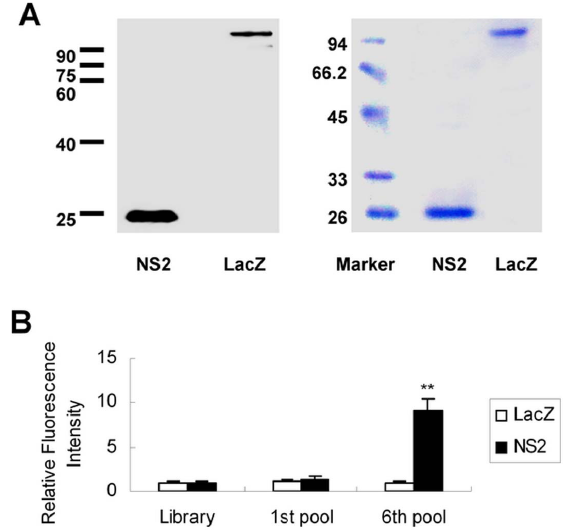
Figure 1. Binding of DNA pools from round 1 and round 6 to NS2 protein. ( A ) Western blot analysis of purified NS2 protein. His- tagged NS2 was expressed by IPTG induction in E. coli BL21 and then confirmed using mouse anti-His monoclonal antibody via western blot (left) and Coomassie Brilliant Blue staining (right). ( B ) Comparison of fluorescence of different pools of FITC-labeled DNA binding to NS2 protein or control LacZ protein. FITC-labeled DNA pools from round 1 or round 6 were incubated with nickel beads conjugated with NS2 or control protein. The density of the fluorescence was measured and normalized to library. Results are the average of three independent experiments. ** P , 0.01 verse library.